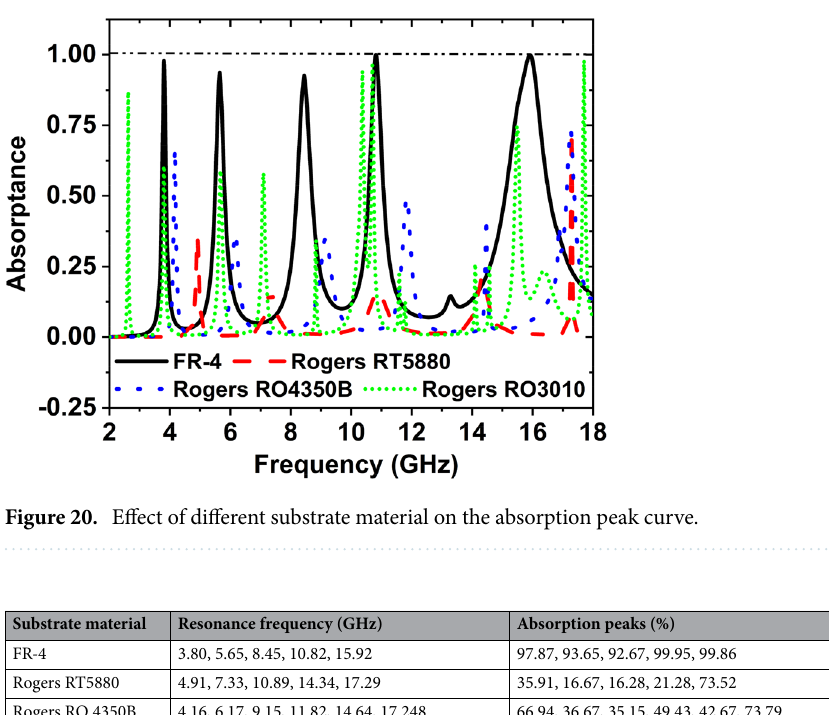
Table 9. Change of absorption peaks and frequencies with the different substrate material.